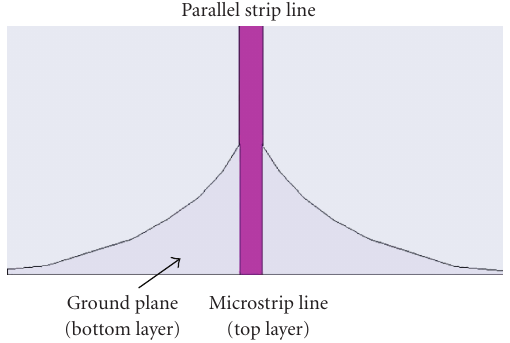
Figure 2: Configuration of the parallel strip line to microstrip tran- sition.